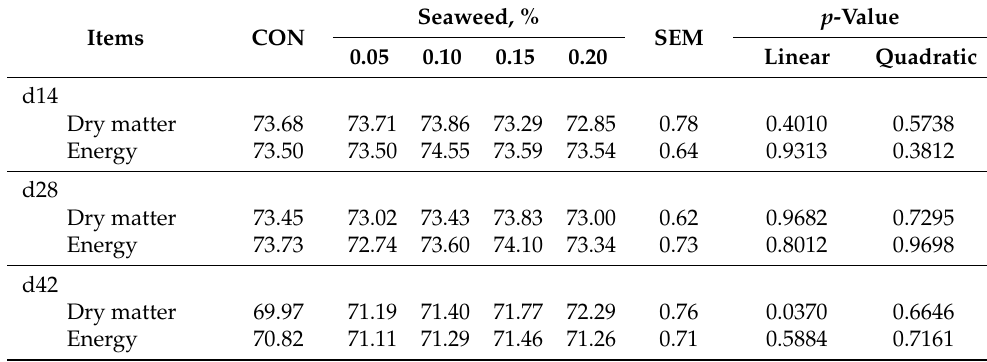
Table 5. The effect of red seaweed supplementation on nutrient digestibility in broilers 1 . Items CON